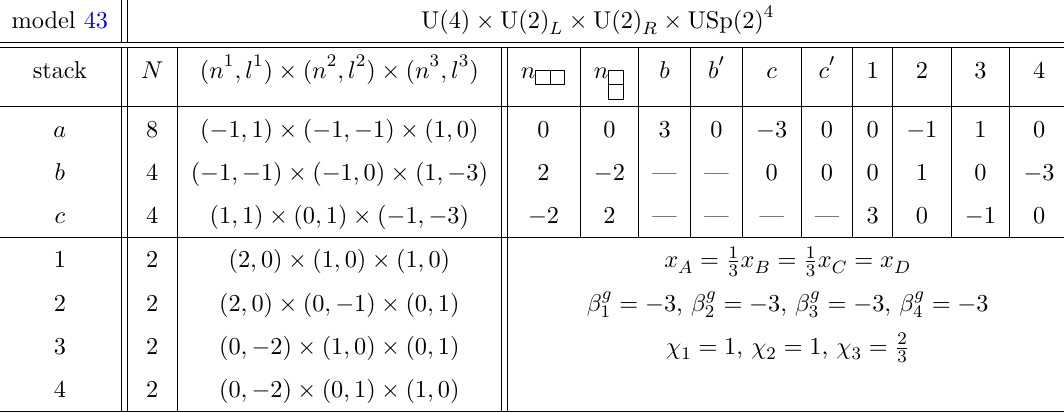
Table 43 . D6-brane configurations and intersection numbers of Model 43, and its MSSM gauge